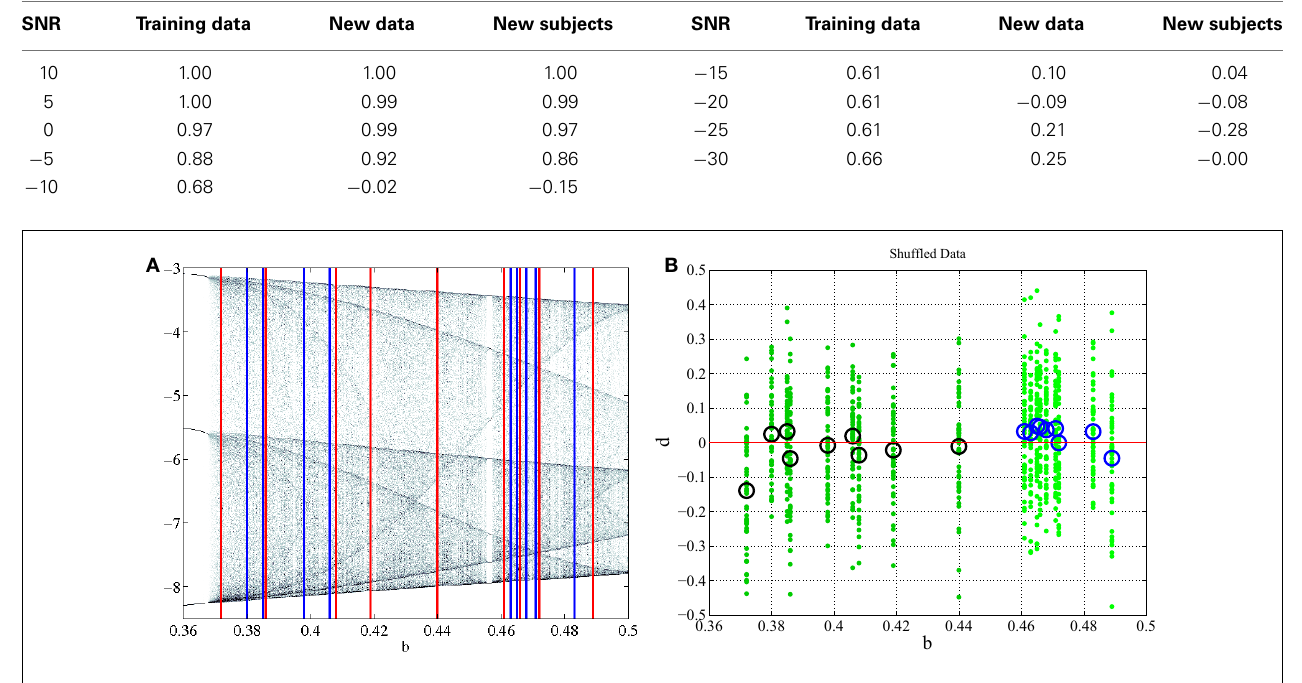
FIGURE 5 | Subject shuffling . (A) PD subjects, red, and CO subjects, blue, are randomly placed in the bifurcation range without any separation between their ranges. (B) After retraining and retesting, b is plotted against d .There is no longer a correlation between input b and output d of the classification